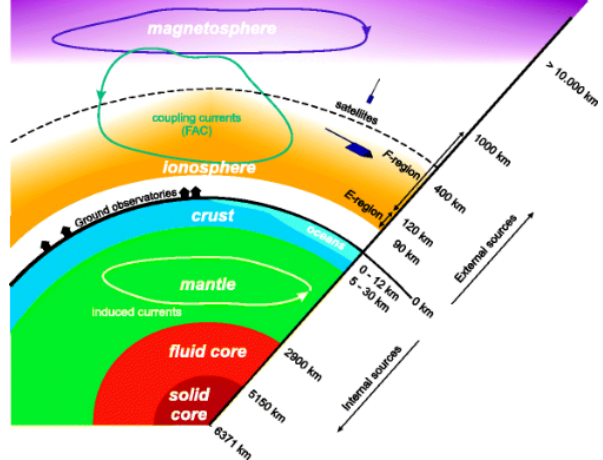
Figure 1. Sketch of the various sources contributing to the near- Earth magnetic field (from Olsen et al., 2010).